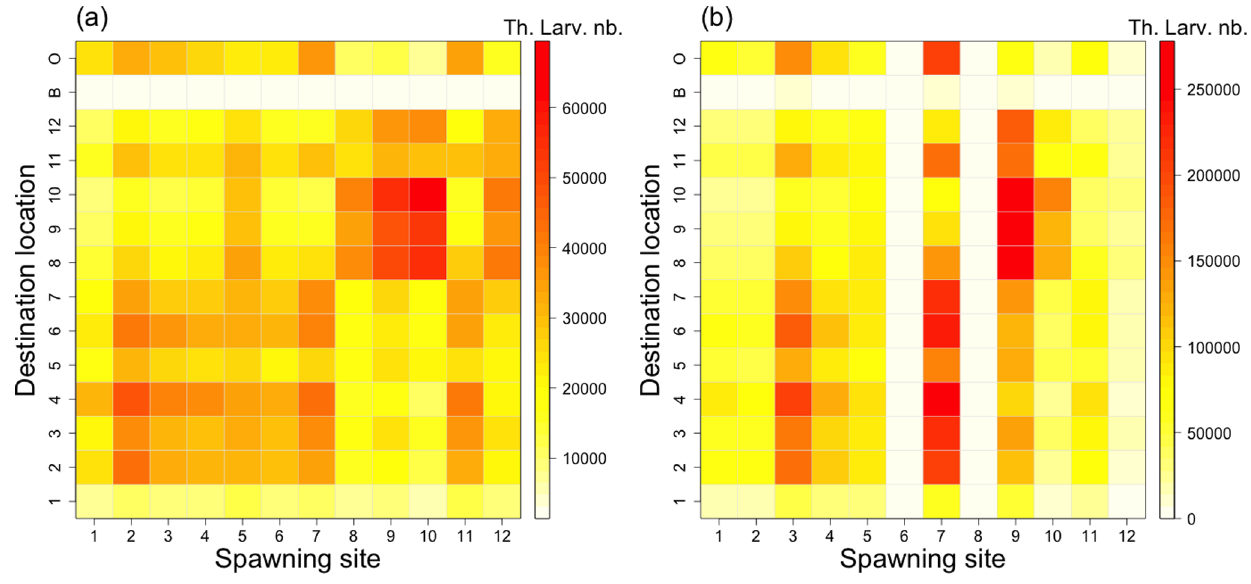
Figure 6. Realistic connectivity matrix ( i.e. , theoretic larval number). The realistic connectivity corresponds to the mean potential connectivity (see Figure 5), spatially weighted in spawning sites by (a) the natural broodstock density and (b) the reared broodstock density, respectively. In the destination locations, ‘‘B’’ represents the shallow waters and ‘‘O’’ the open ocean.